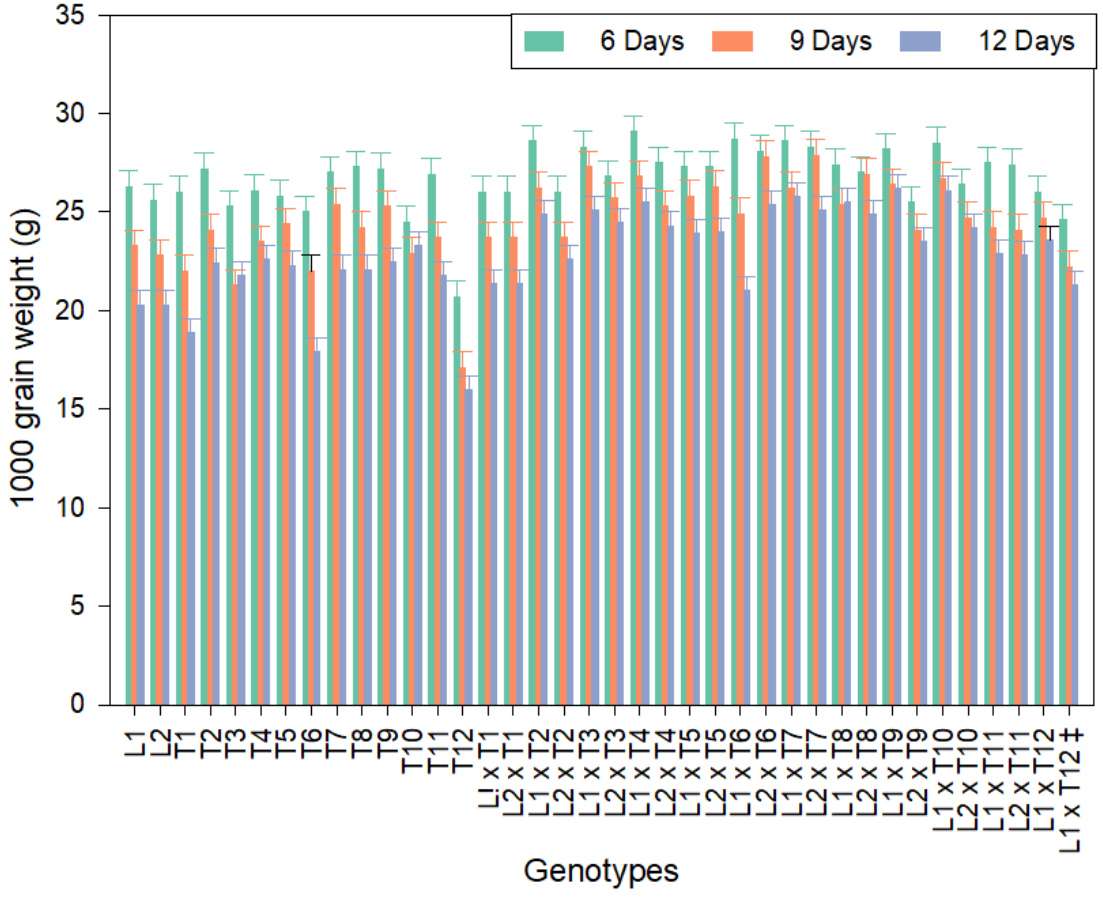
Figure 1. The performance of 1000-grain weight for the newly developed hybrids and their parental rice lines under the three irrigation regimes (6, 9, and 12 days). ‡ : control hybrid. Bar represents the LSD at 5%; 0.8, 0.8, and 0.7 for the 6-, 9-, and 12-day irrigation regimes, respectively.